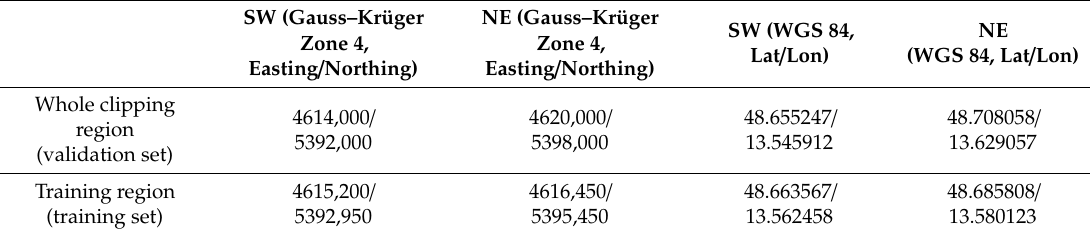
Table 1. Coordinates of clipped region and training region.